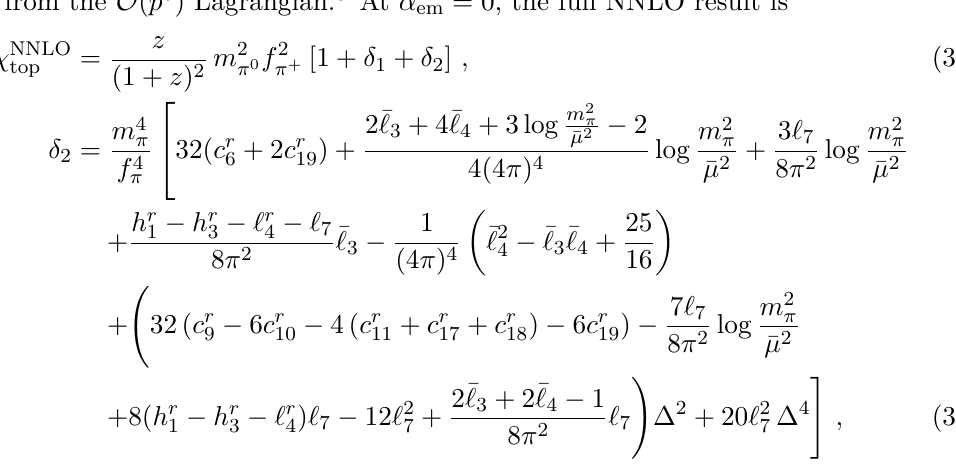
= 0, the full NNLO result is em